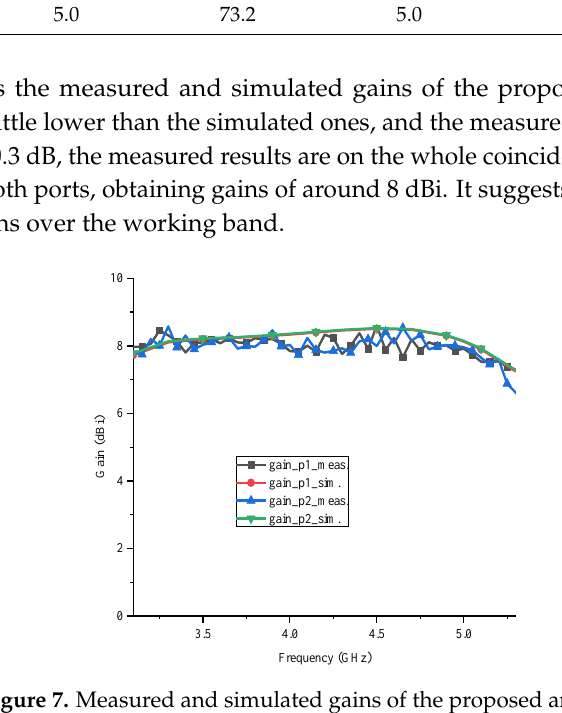
Figure 7. Measured and simulated gains of the proposed antenna.